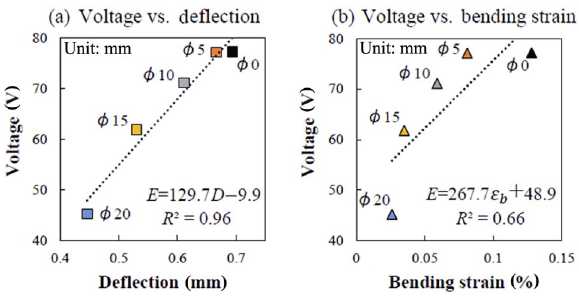
Fig. 12 Voltage generated by PZT ceramic as a function of (a) deflection and (b) bending